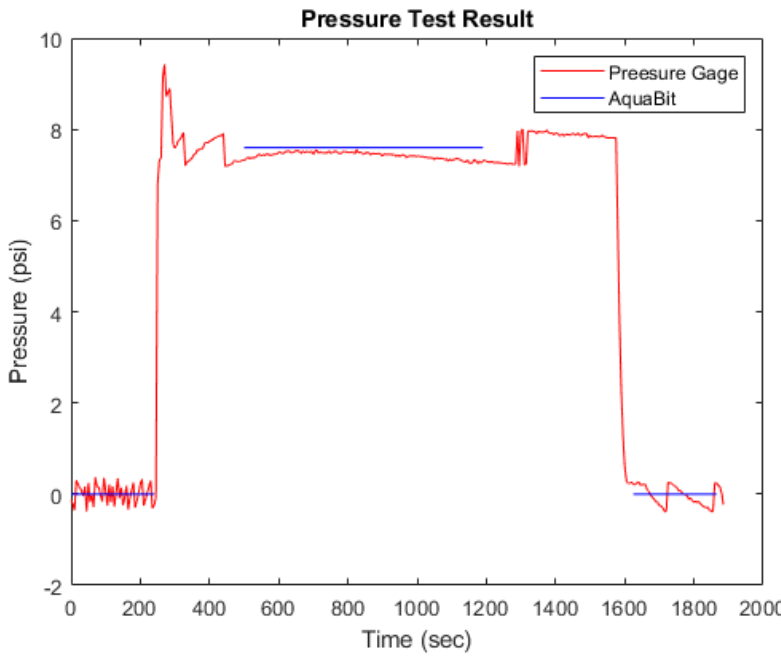
Figure 14. Pressure sensor test in water result.